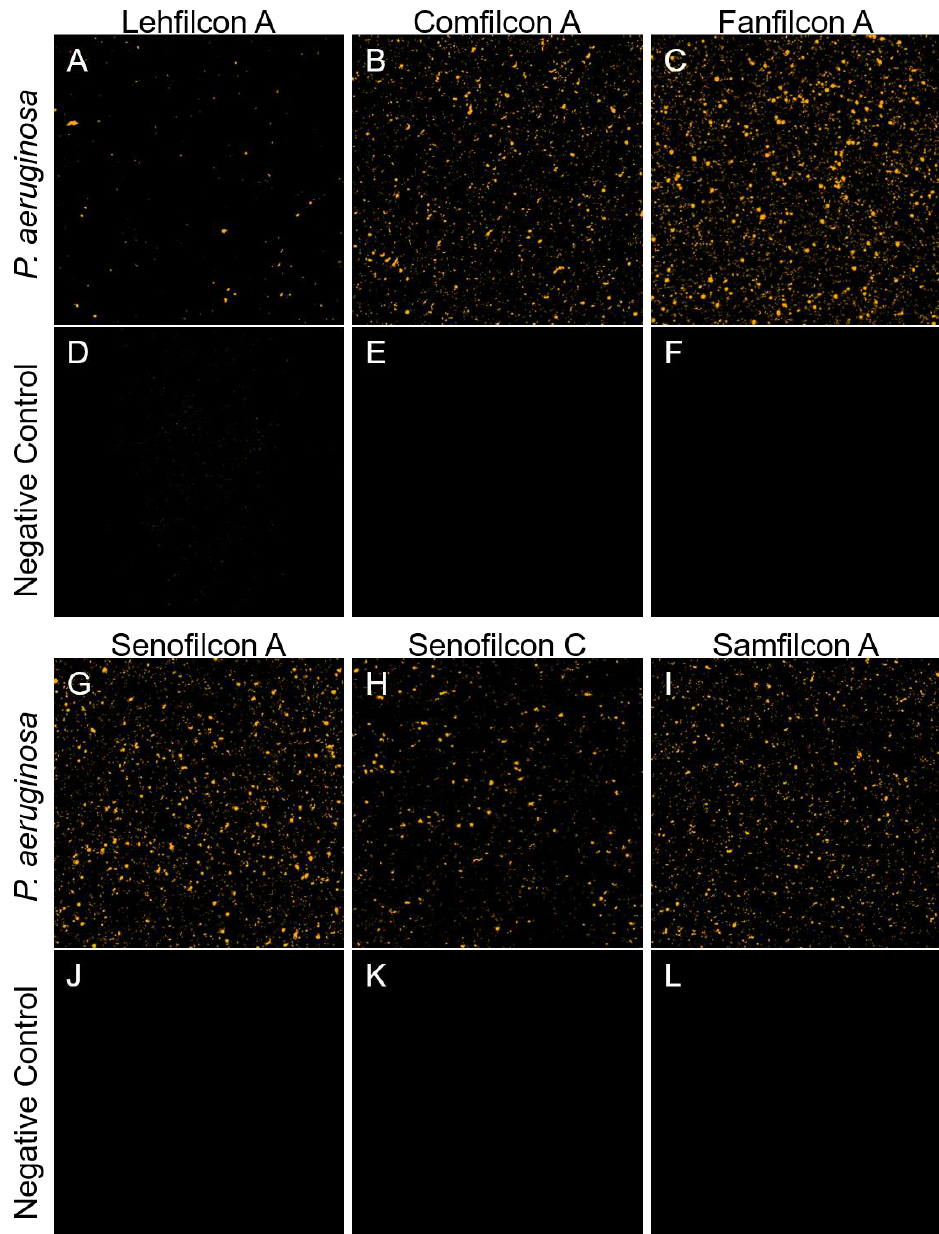
Figure 1. Qualitative assessment of P. aeruginosa’s adherence to soft contact lenses. Confocal microscopy of contact lenses treated with TAMRA-stained P. aeruginosa strain ATCC 10145 ( A – C , G – I ) or mock treated with sterile PBS ( D – F , J – L ). Bacteria are visible as foci attached to the surface of lehfilcon A ( A ), comfilcon A ( B ), fanfilcon A ( C ), senofilcon A ( D ), senofilcon C ( E ), or samfilcon A ( F ). A 0.42 × 0.42 mm field of view from the center of each contact lens is